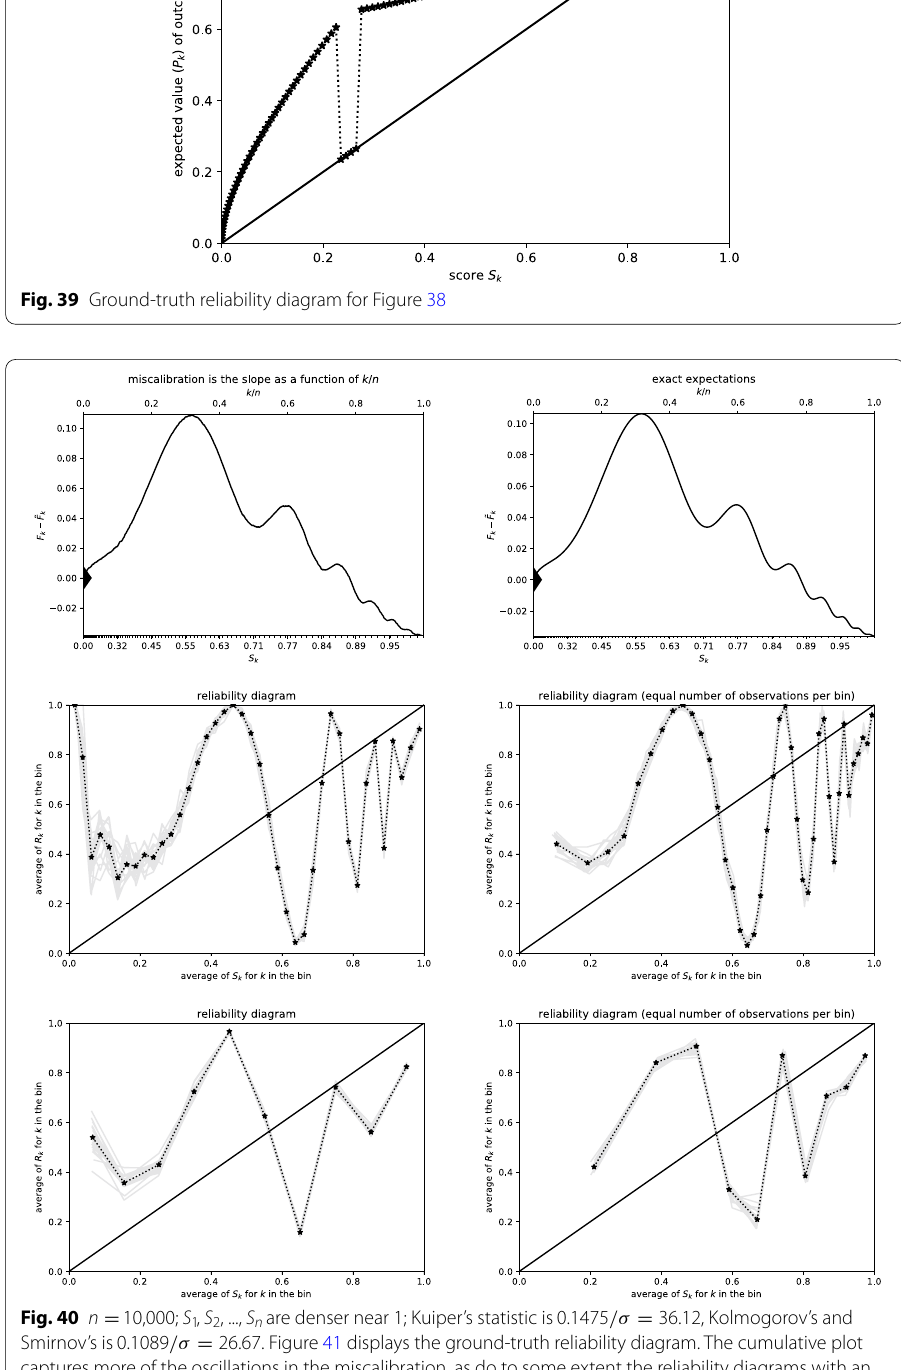
Fig. 40 n = 10,000; S 1 , S 2 , ..., S n are denser near 1; Kuiper’s statistic is 0.1475 /σ = 36.12 , Kolmogorov’s and Smirnov’s is 0.1089 /σ = 26.67 . Figure 41 displays the ground-truth reliability diagram. The cumulative plot captures more of the oscillations in the miscalibration, as do to some extent the reliability diagrams with an equal number of observations per bin; however, the variations in the reliability diagrams could be difficult to interpret without access to the ground-truth exact